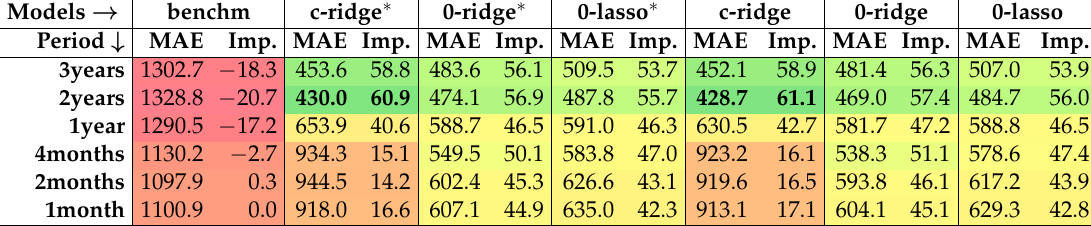
Table 1. Out-of-sample MAE in MW with relative improvement in % with respect to the benchmark trained on the shortest training period for all models and training periods. A heat map is used to indicate better ( green) and worse ( red) performing → →